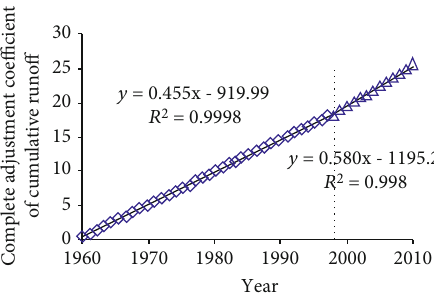
Figure 8: Complete adjustment coe ffi cient of cumulative run.